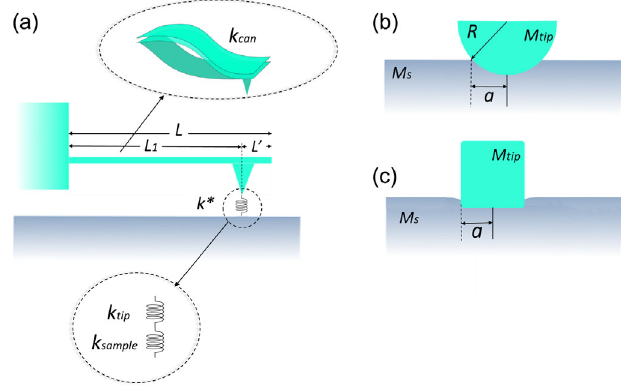
FIG. 2. (a) Schematic presentation of AFM cantilever and tip- sample contact being simulated by a spring with constant k (cid:2) . (b) Diagram of tip-sample contact based on a Hertzian mechani- cal contact model and (c) flat punch contact between the tip and the sample.